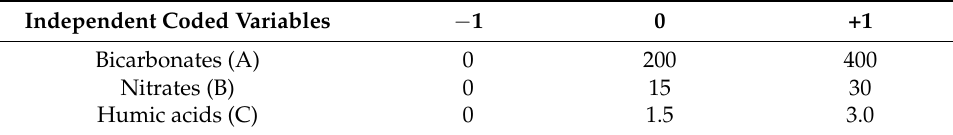
Table 2. Independent coded variables (quantities in mg/L) corresponding to the second DoE. Independent Coded Variables −